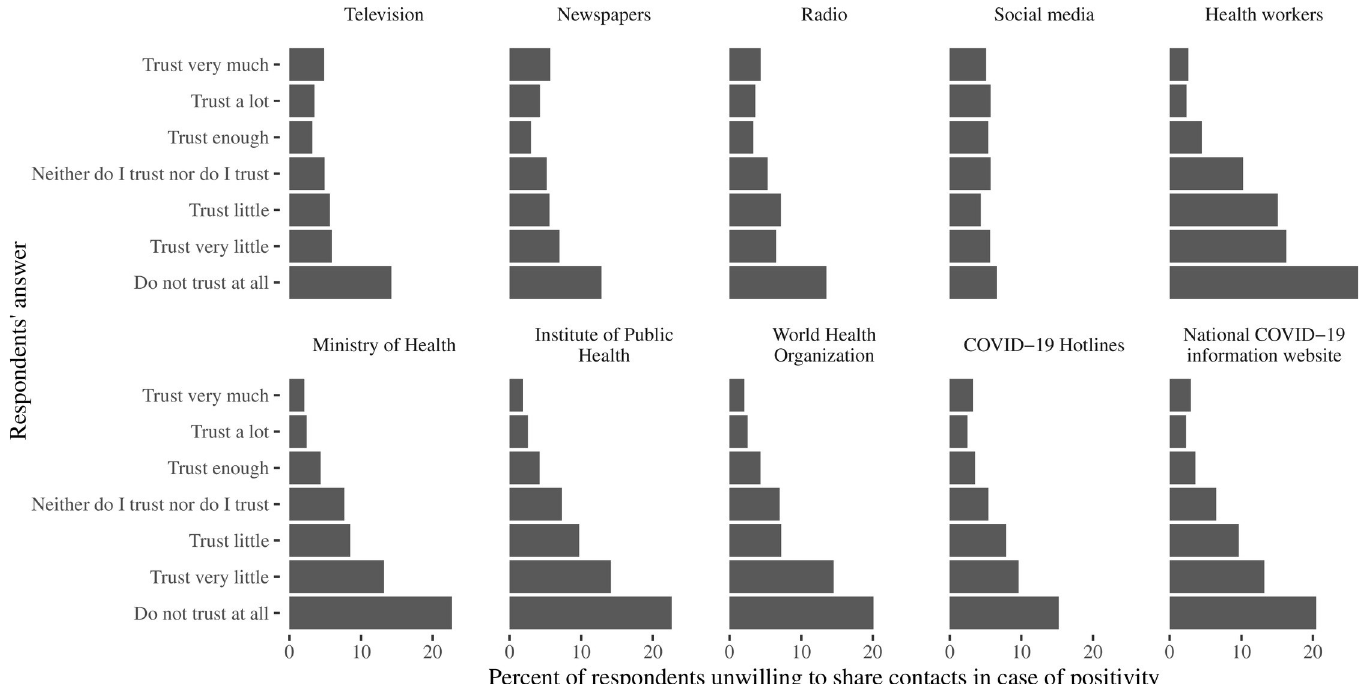
Fig 4. Percent of respondents who expressed unwillingness to share contacts in case of positivity, according to their response to the questions “How much you trust to the information about the COVID-19 supplied by the following sources”. The sources of information are named at each panel on the figure.